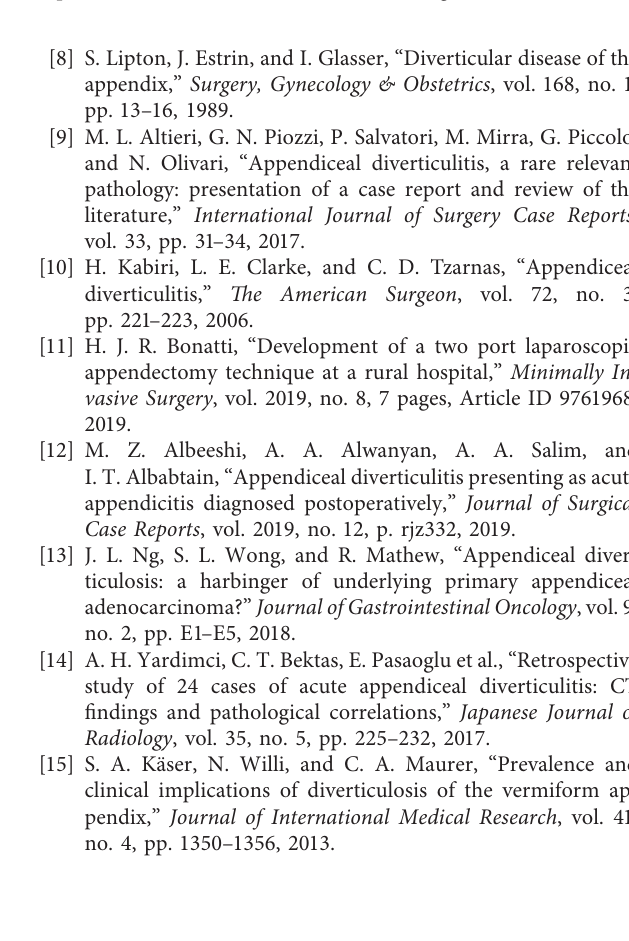
Figure 3: Pathology findings: section of the appendix tip (a) and close up (b) of the diverticulum (arrows) showing acute